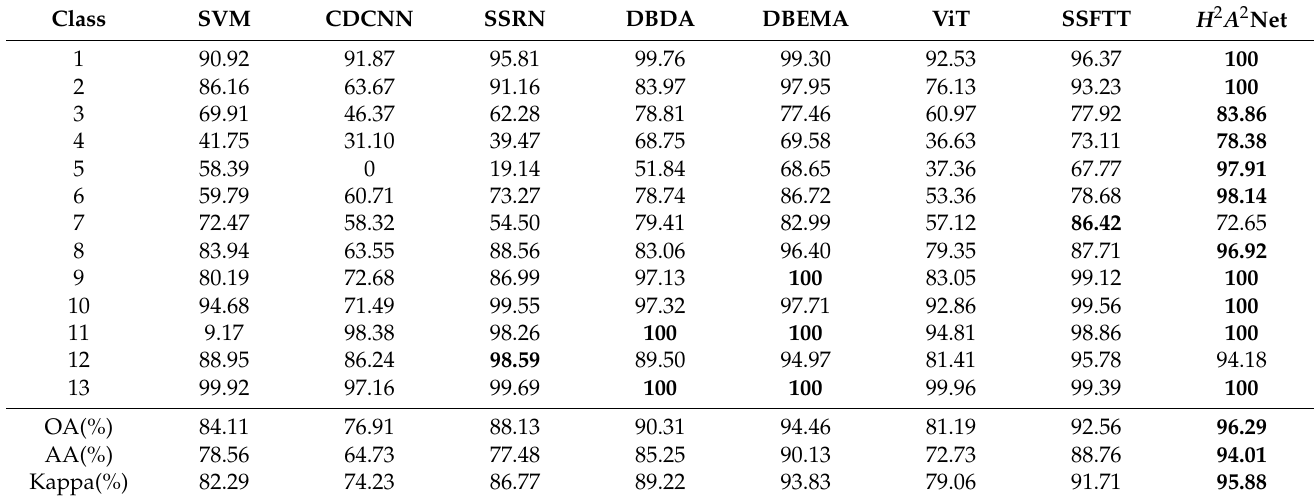
Table 7. The classification accuracy for the HOU dataset based on 3% training samples. Table 8. The classification accuracy for the KSC dataset based on 3% training